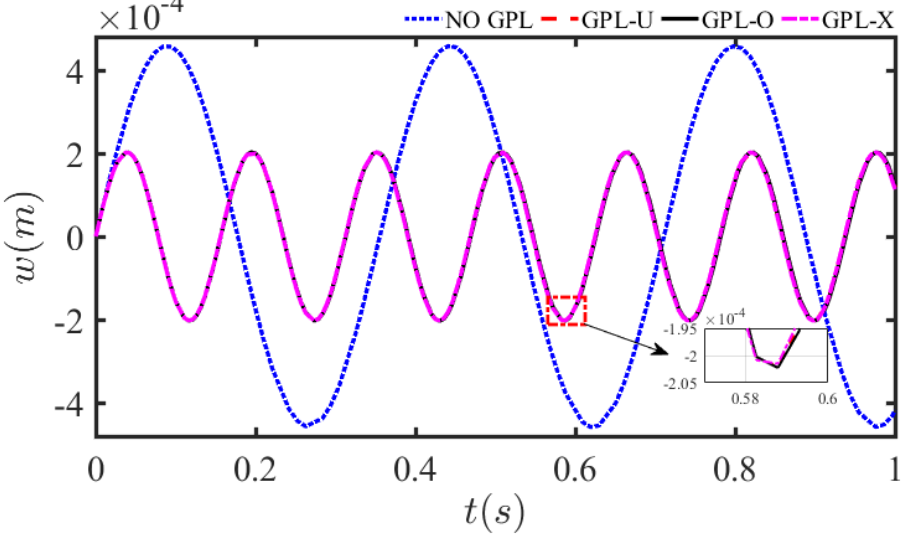
Figure 4. Time history diagram of GPLRC pipes conveying fluid with a uniform disribuiton of GPLs. Figure 5 indicates a higher frequency and lower amplitude of vibrations, because the structural stiffness is increased by the addition of GPLs. However, the amplitude difference of the GPLRC pipes conveying fluid under three distribution modes is not significant. This is because the pipes conveying fluid are slender hollow beam structures with thin thickness. GPL-X distribution is selected for research and discussion.